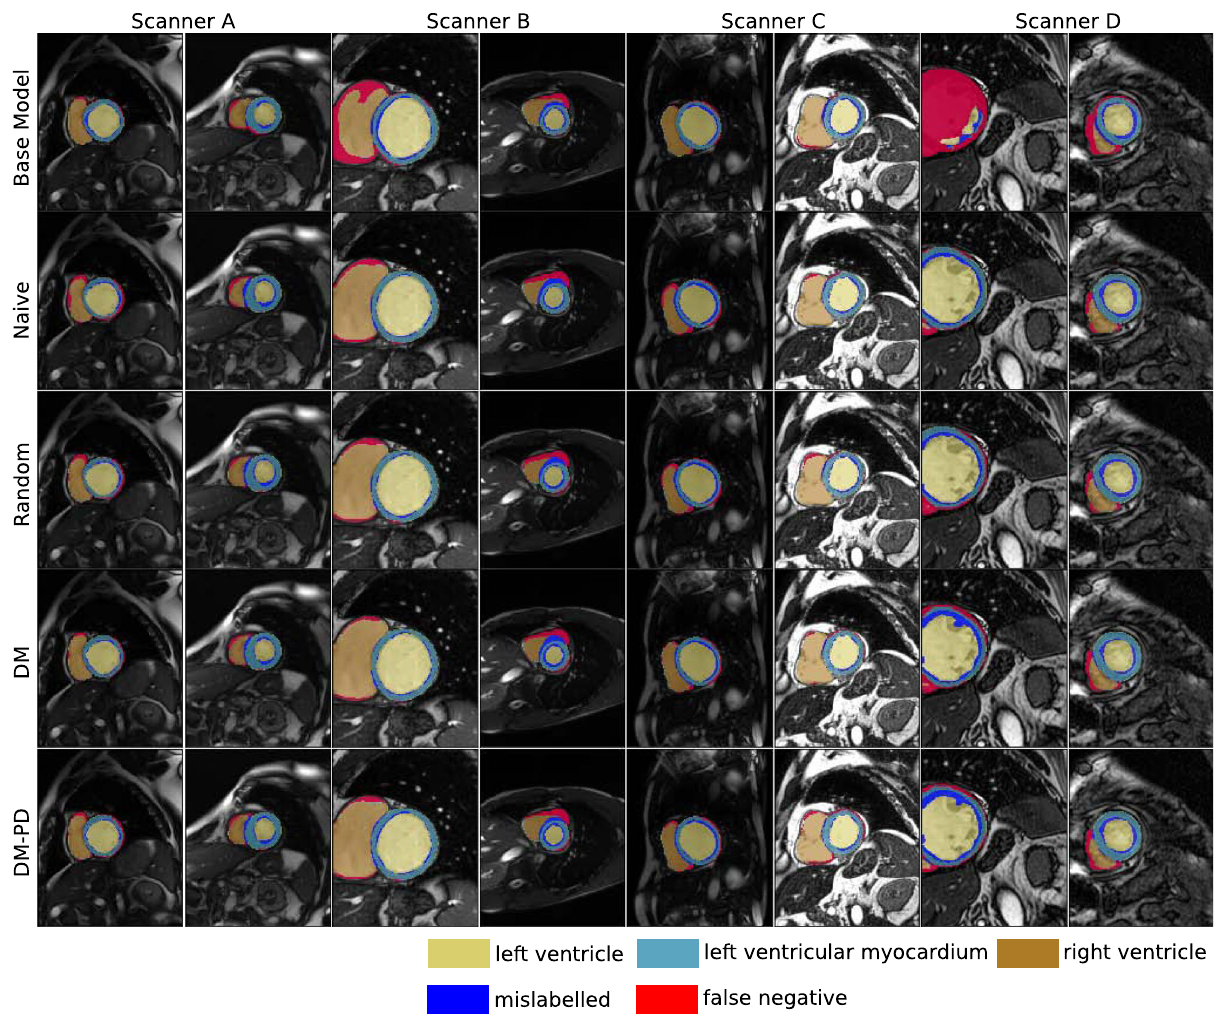
Fig. 3 Qualitative examples for cardiac segmentation. Results for DM and DM-PD with M = 128 compared to naive continual learning and random memory replacement. Mislabelled refers to pixels that were labelled, but the class membership was confused by the model. The base model was trained in a static training approach on data from Scanner A